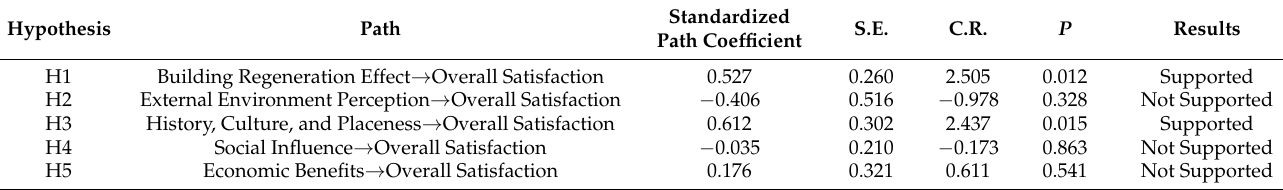
Table 5. Results of the path hypothesis test